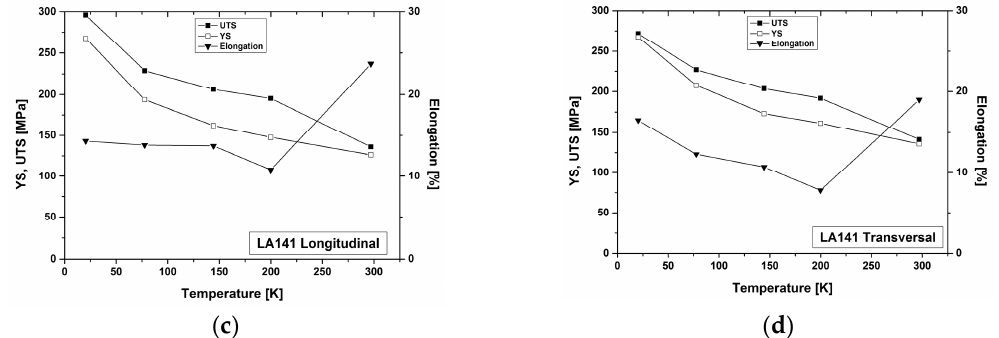
Figure 5. Tensile properties of magnesium alloys, LA91 in ( a ) and ( b ) and LA141 in ( c ) and ( d ), in longitudinal and transverse direction (redrawn from [20]).